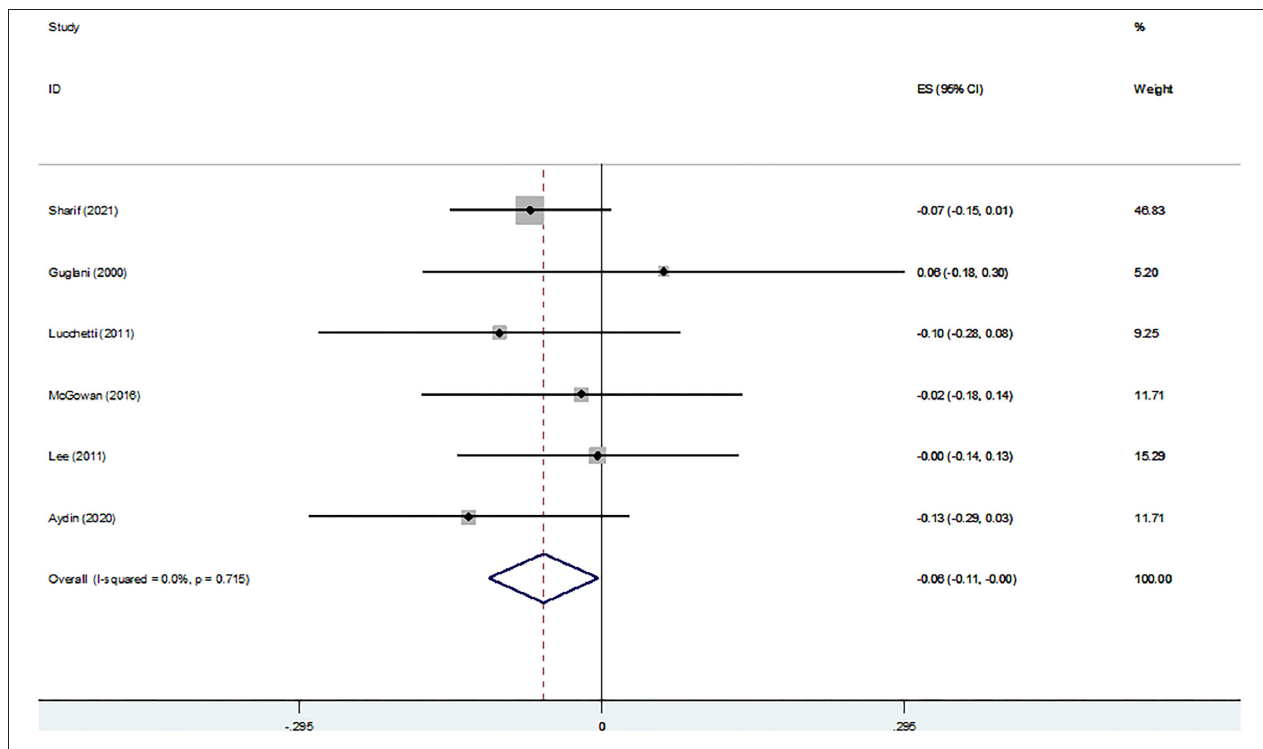
FIGURE 2 | Z-scores for